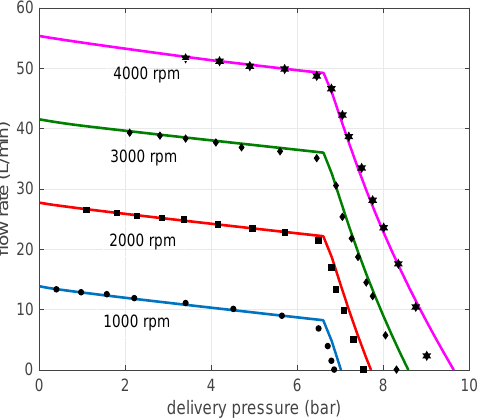
Figure 19. Simulated and measured steady state characteristics at 65 °C and four speed values.